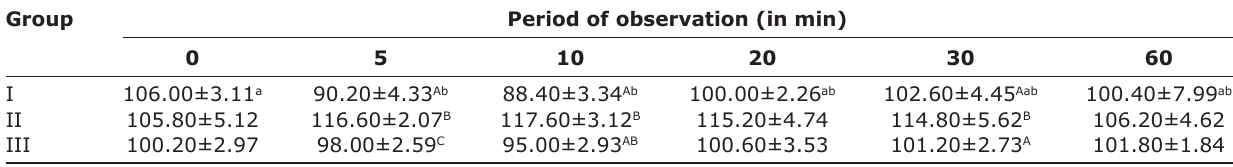
Values with same superscripts in a column (capital letters) did not differ significantly (p>0.05). Values with same superscripts in a row (small letters) did not differ significantly (p>0.05). SE=Standard error Table-3: Mean±SE value of heart rate (beats/min) of different groups at different time intervals of observation. Group Period of observation (in min)